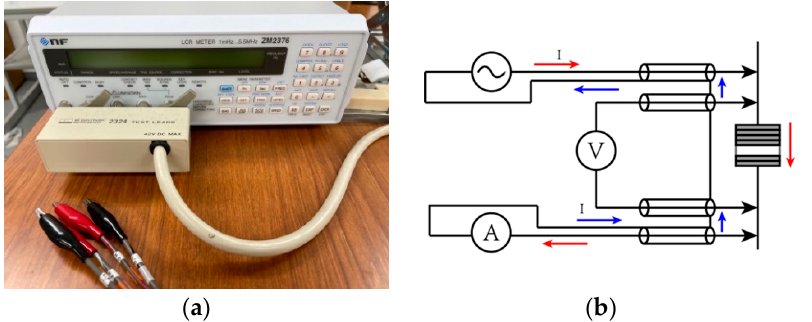
Figure 5. ( a ) LCR meter (ZM2376, NF Co., Ltd., Japan); ( b ) four-terminal connection method for the LCR meter system.